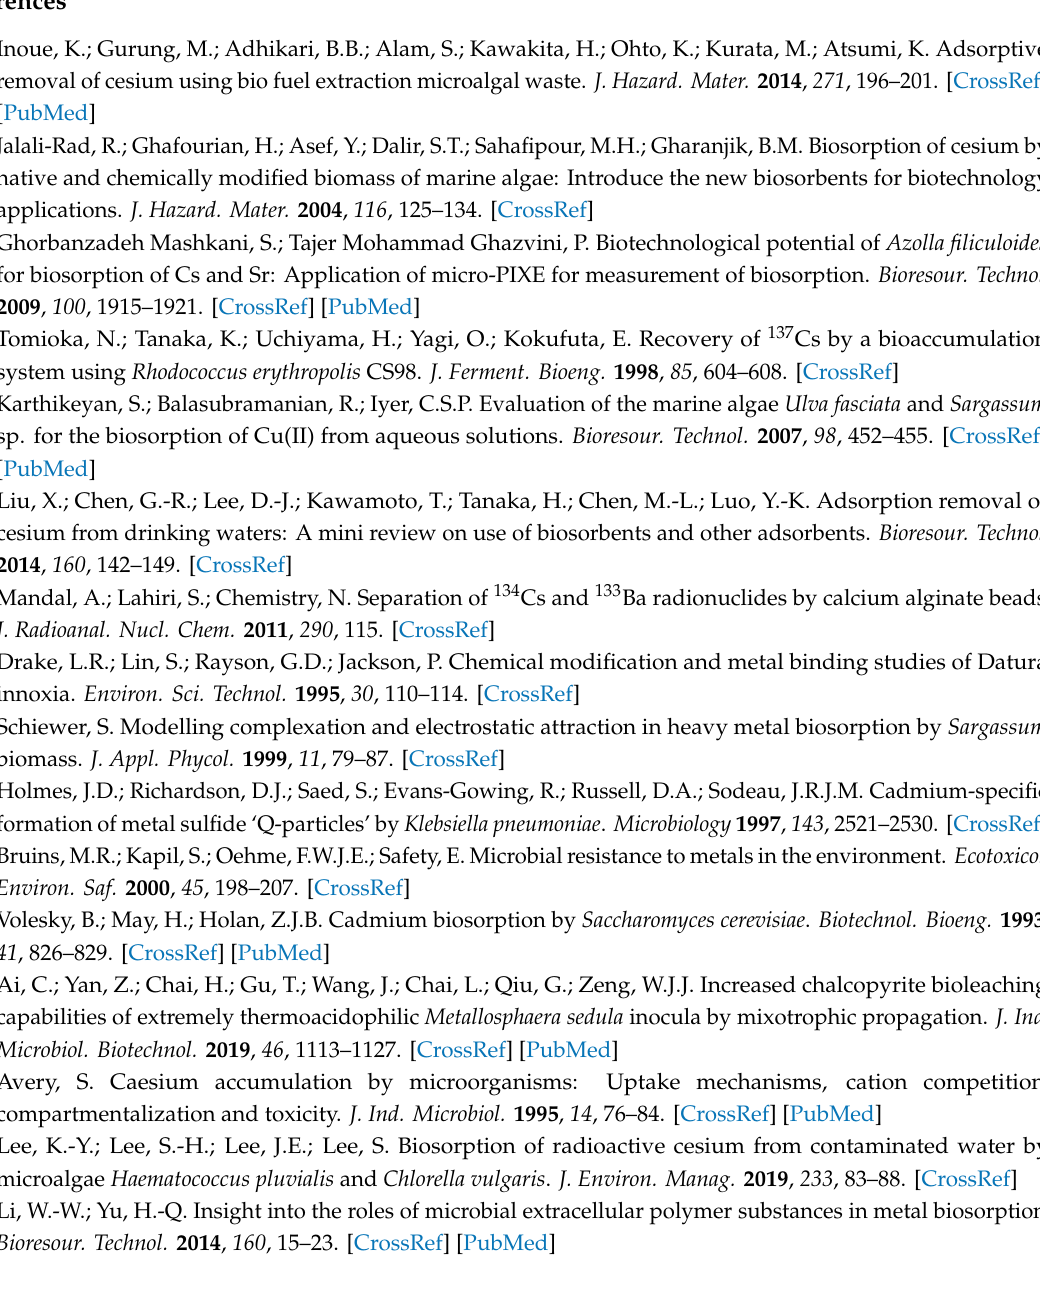
Figure S1: E ff ect of contact time on the biosorption of Cs(I) on Synechococcus PCC7002 from aqueous solutions: initial concentration Cs ions 300, 500 and 700 mg / L. Figure S2: Raman spectra of Synechococcus PCC7002 (a) and Cs-loaded Synechococcus PCC7002 (b). Figure S3: E ff ect of pH on adsorption of Cs(I) onto Synechococcus